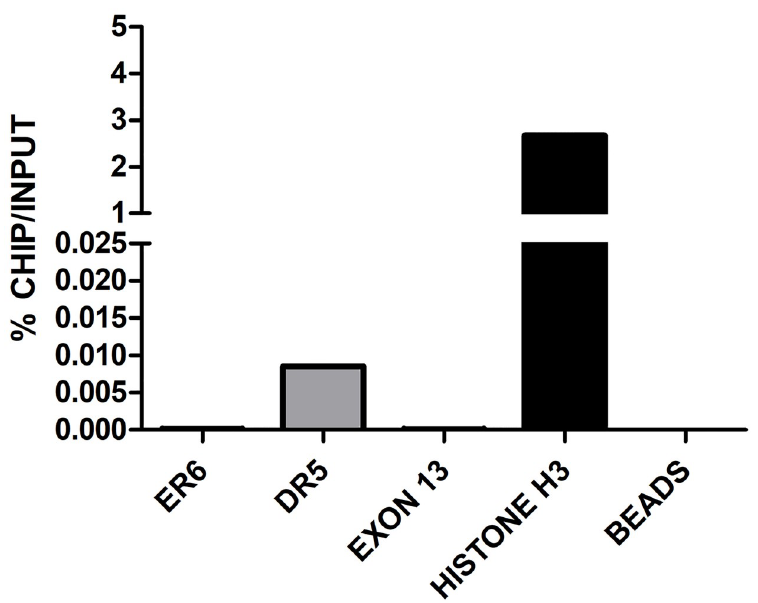
Fig 9. ChIP in control BFH12 cells to quantify the binding of CAR to ER6 and DR5 binding sites. BFH12 cells were exposed to 0.1% DMSO for 6 hours. Chromatin was then isolated, subjected to ChIP using anti-human CAR antibody and quantified by qPCR as described in S1 File. Results for both ER6 and DR5 DNA regions are reported. Data are normalized to input DNA and expressed as % ChIP/input. The experiment was performed four times independently, and similar results were obtained. The data shown derived from a representative experiment. Chromatin samples from control cells immunoprecipitated with or without Histone H3 antibody are shown as Histone H3 and beads, respectively. A further negative control (exon 13), representing a CYP3A28 DNA region without NR binding sites, is reported in the graph. In all experiments, negative and positive controls behaved as